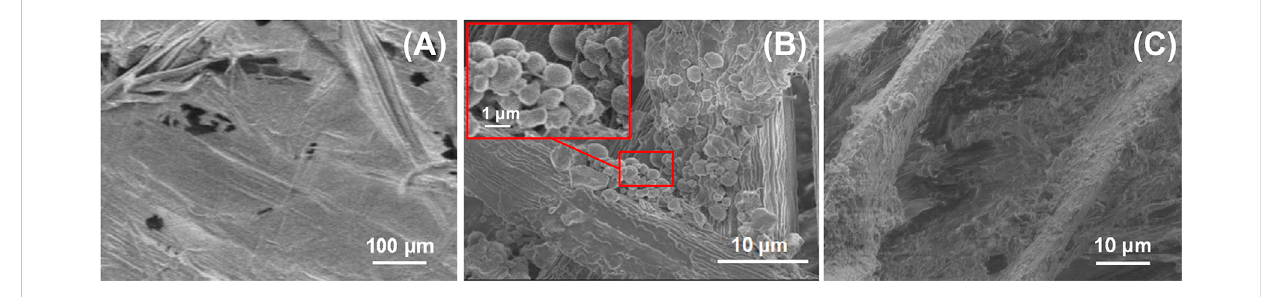
FIGURE 4 SEM images of (A) BPC, (B) BPC-TiO 2 , and (C) BPC-TiO 2 -F.